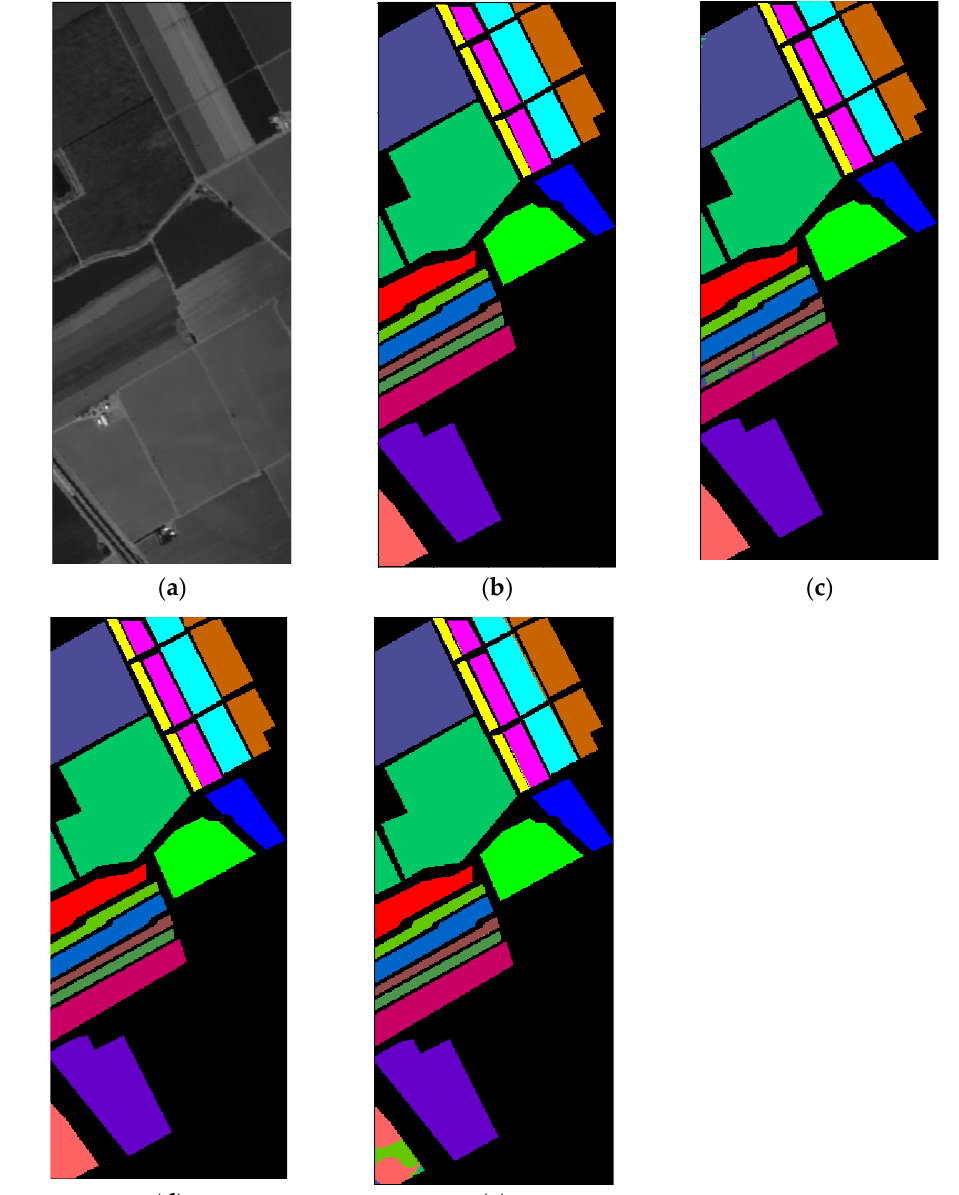
Figure 6. The classification map for the PaviaU dataset: ( a ) original image, ( b ) ground truth, and ( c – e ) classification maps obtained using LRCNet, HybridSN, and DSSNet, respectively.